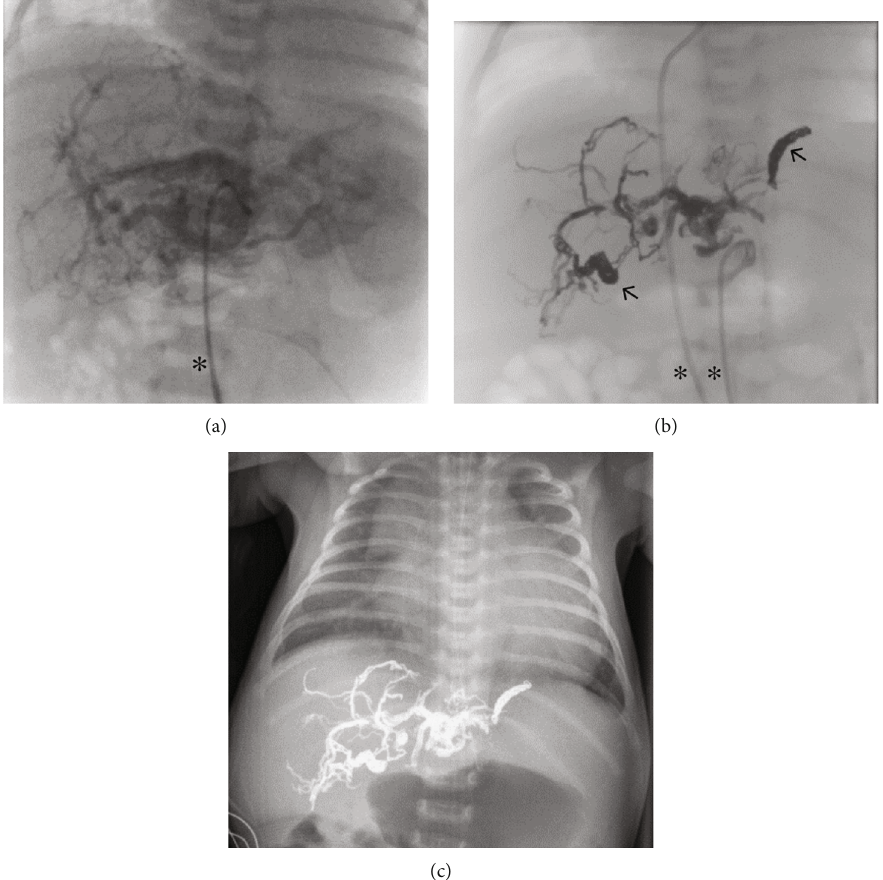
Figure 2: Imaging of the hepatic AVM in patient 4. (a) Angiographical imaging after injection of Solutrast 300® into the feeding arteries via transarterial catheter (asterisk). (b) Angiographical imaging after injection of radiopaque Onyx® and Concerto Helix©-coils (arrows; two transvascular catheters are marked by asterisks). (c) Radiographic imaging (X-ray) of the thorax and upper abdomen after the last embolization, still existing extensive